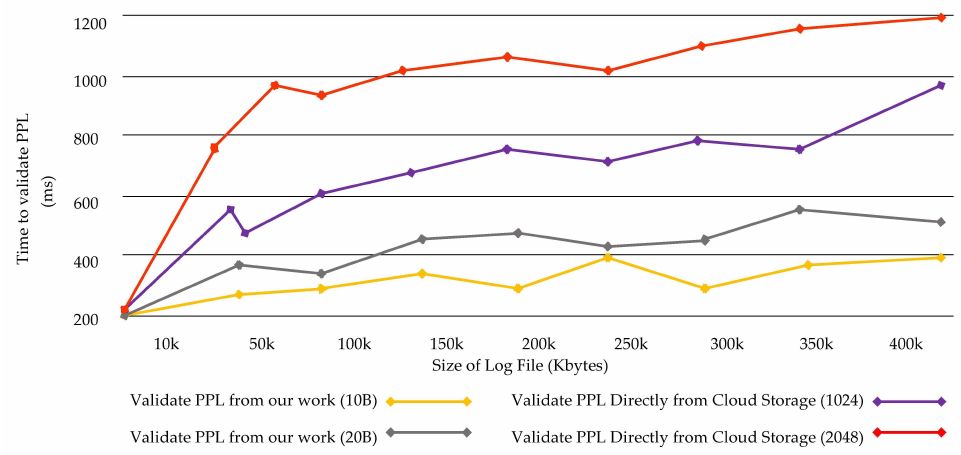
Figure 21. PPL validation processing performance among fog and